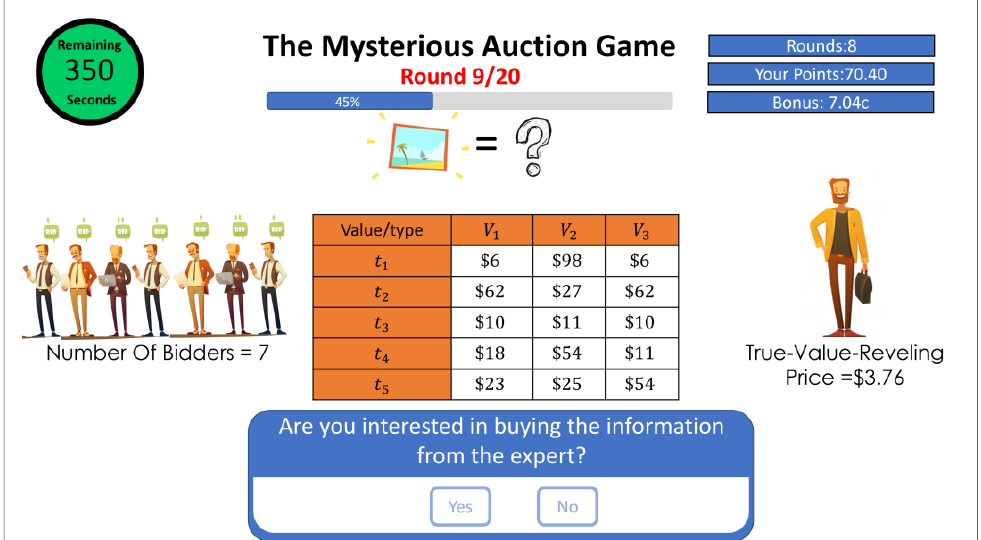
Figure 2. Screenshot of the Mysterious Auction Game. On the left side of the screen appears the number of bidders taking part in the auction. On the center of the screen appears a table including both the number of possible world states, the number of bidder types, and the matrix that contains the different types’ valuation of the auctioned item for every possible world state. On the right side of the screen appears the price required for the information.